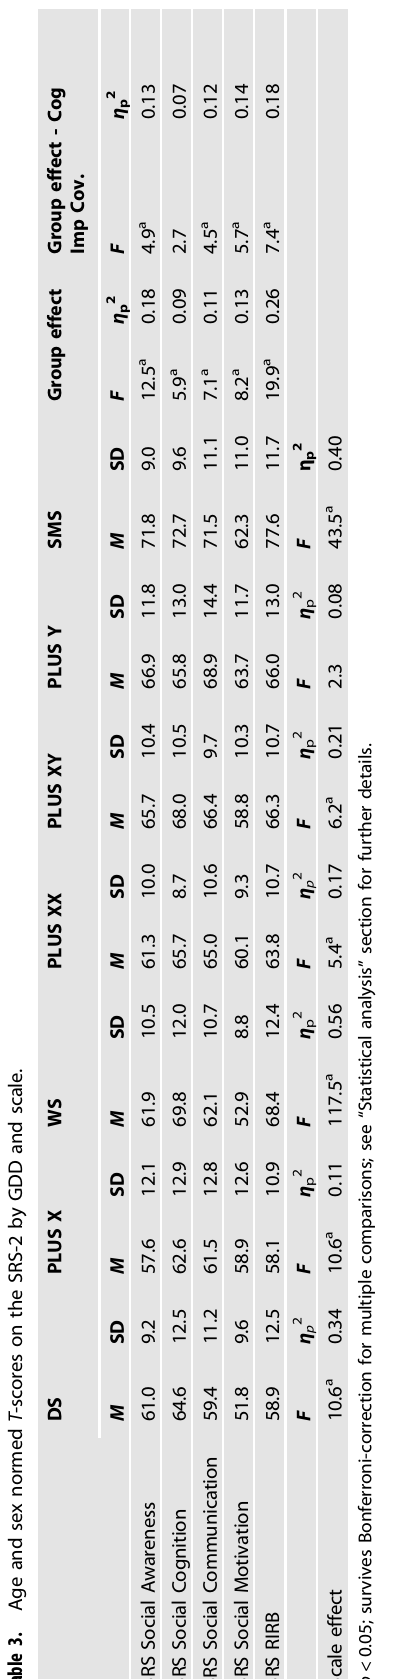
ARTs across GDDs. The proportion of variance explained by GDD group differed between ART subscales, with a high of 26% (RIRB) variation across ART subscales was also observed for all GDDs, except the + Y group. Next, as is common practice in neurodevelopmental disorders research [22, 35 – 37], SRS-2 pro fi le differences (i.e., differences in the pattern of test scores/strengths and weakness) were evaluated using a series of mixed-model ANOVAs (or ANCOVAs covarying for cognitive impairment). Speci fi cally, 21 mixed model ANOVAs/ ANCOVAs (each consisting of one between-subjects factor [group: GDD1 vs. GDD2] and one within-subjects factor [SRS-2 subscale]) were completed. For these analyses, group effects indicating an overall difference in the magnitude of impairment between two groups (e.g., GDD1 is more/less impaired than GDD 2 overall) and group*subscale interaction effects (e.g., GDD1 and GDD2 have a different pattern of scores on the SRS-2 subscales) were evaluated. The results of these ANOVAs and ANCOVAs are presented in Fig. 1 (upper and lower triangles, respectively). As seen in Fig. 1, when a main effect of group (i.e., a difference between the two GDDs being compared in the overall magnitude of impairment) was identi fi ed, the cell in the matrix was color coded blue. When there was a group*subscale interaction (i.e., the pro fi le or pattern of SRS- 2 subscale scores differed between the two GDDs being considered), the cell was color coded yellow. Lastly, instances in which there was both a main effect of group (magnitude of impairment) and a group*subscale interaction (SRS-2 pro fi le difference) were color coded green. As evidenced by the preponderance of yellow cells in the matrix, the most common form of between-group ART differences was for the pro fi le of ART scores in the absence of group differences in overall ART severity, regardless of whether cognitive impairment was covaried. The GDD groups that most differed from others in their SRS-2 pro fi les were the WS and plusX groups. The SMS group was notable for often showing differences in overall SRS-2 scores and pro fi le. The data underlying the statistical comparisons detailed above are presented visually in Figs. 2 and 3. For those pairwise GDD comparisons characterized by group*subscale interactions, follow- up pairwise t -tests were completed to identify which SRS-2 subscales differed between and within GDD groups (see bottom panels of Figs. 2 and 3, respectively). For results with cognitive impairment covaried, see Supplementary Table 2. ART – IQ relationships across GDDs and SRS-2 subscales Analysis of variance comparisons of nested mixed models failed to fi nd evidence that relationships between SRS-2 scores and cognitive impairment are signi fi cantly modulated by interactive effects of GDD and ART subscale ( p = 0.57). However, the relationship between cognitive impairment and ART scores did vary signi fi cantly as a function of subscale (controlling for a main effect of GDD group, p < 10 − 10 ). Thus, different SRS-2 subscales vary from each other in the nature of their relationships with cognitive impairment, but this does not differ signi fi cantly across GDD groups. Given these results, standardized regression coef fi cients were estimated for IQ as a predictor of each SRS-2 score while controlling for the main effect of GDD group. This revealed that greater cognitive impairment was associated with more severe ARTs for all subscales, but that the magnitude of this relationship (i.e., regression slope, β ) varied by ART subscale: Soc_Cog ( β = 0.3, p = 0.000002), Soc_Com ( β = 0.28, p = 0.00002), RIRB ( β = 0.26, p = 0.01). Although GDD group did not signi fi cantly modulate the relationship between the SRS-2 subscales and cognitive T a